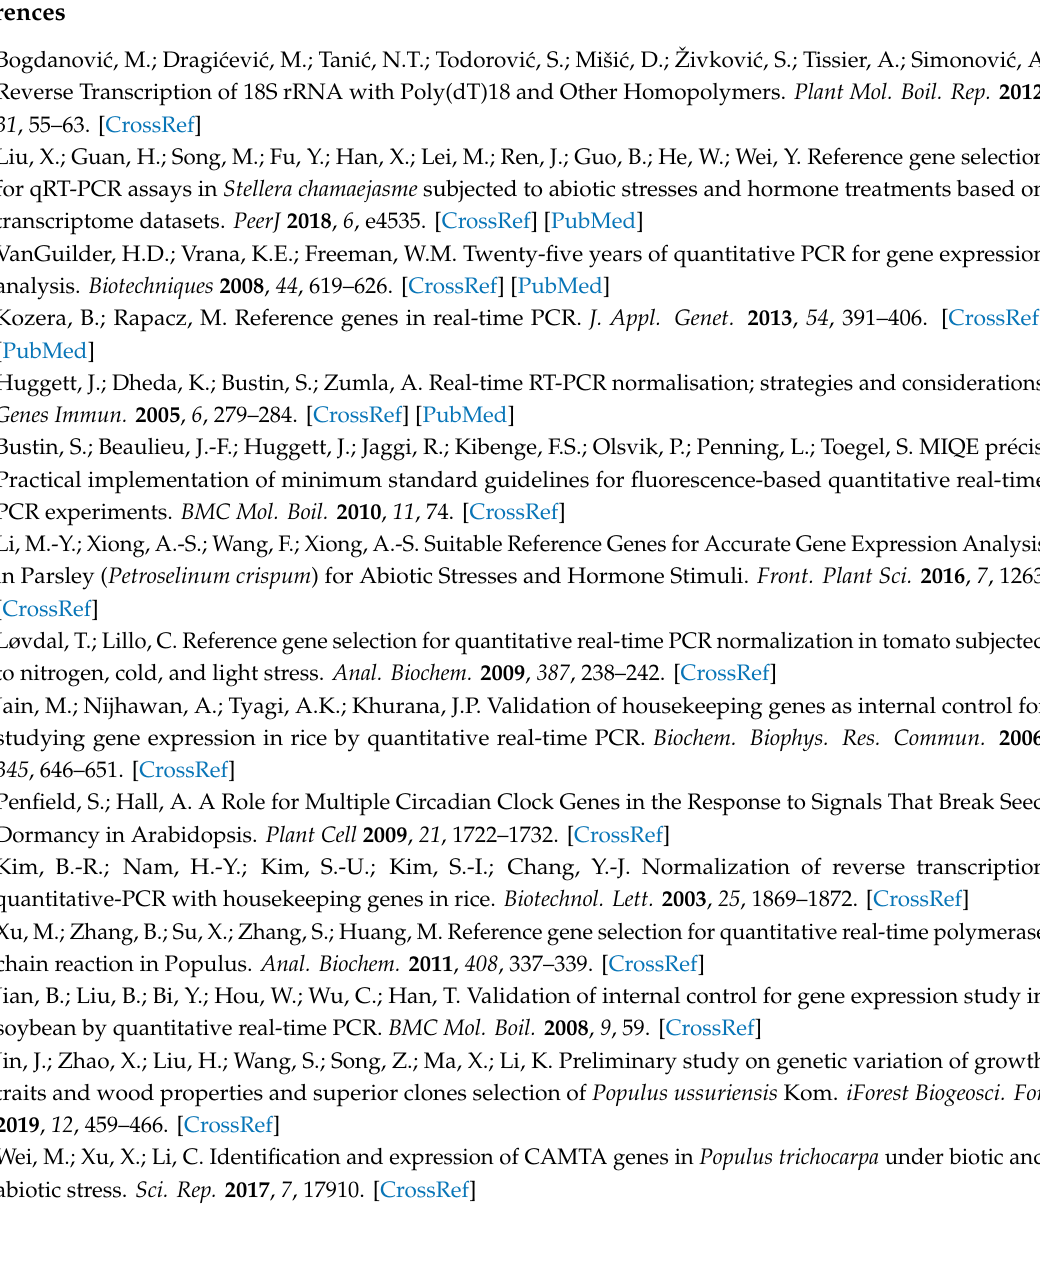
Figure S1: Agarose gel electrophoresis of PCR products for each of the fourteen RGs and the two target genes; Figure S2: Dissociation curves of the qRT-PCR amplicons for 14